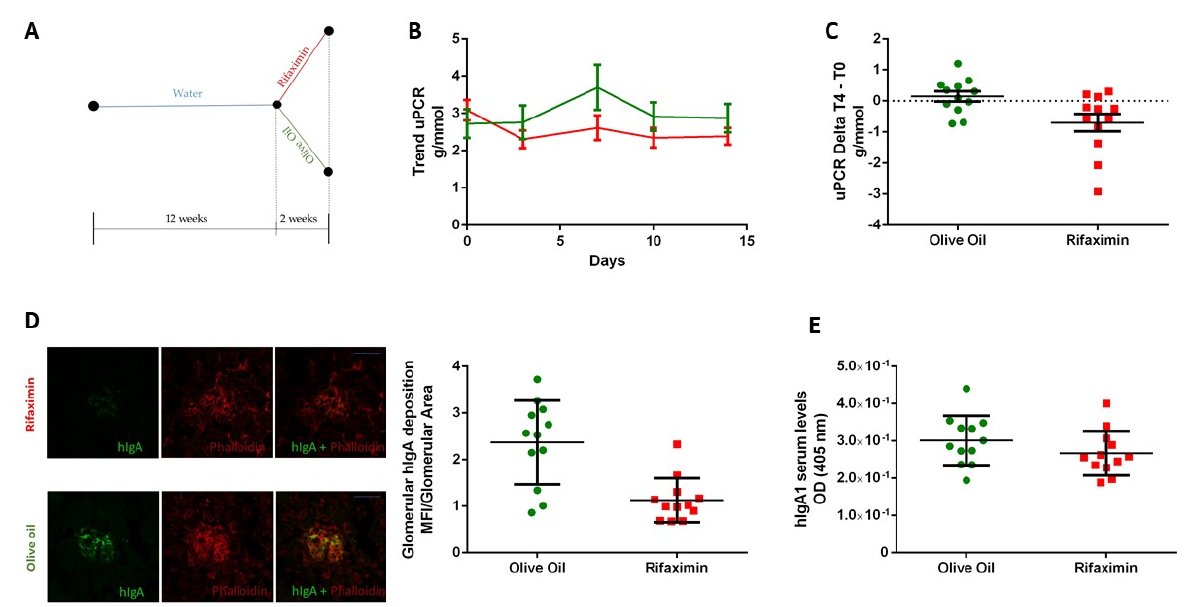
Figure 1. ( A ) Twelve-week-old mice were given 100 mg/kg of Rifaximin or of olive oil by oral gavage for two weeks before sacrifice. ( B ) Trend of uPCR from 12 weeks to sacrifice. ( C ) uPCR Delta t3-t0, where t3 is the uPCR after two weeks of treatment and t0 is uPCR before starting antibiotic or vehicle. ( D ) Representative sections of kidneys after immunostaining with anti-hIgA-FITC antibody and Phalloidin–Alexaflour 564 to underline glomerular structures (green anti-hIgA1, red phalloidin) and the ratio between the glomerular area positive for hIgA1 and total area of the glomerulus, measured using ImageJ. ( E ) hIgA serum level measured by ELISA in mice that received antibiotics or vehicle and compared using the Mann–Whitney test.